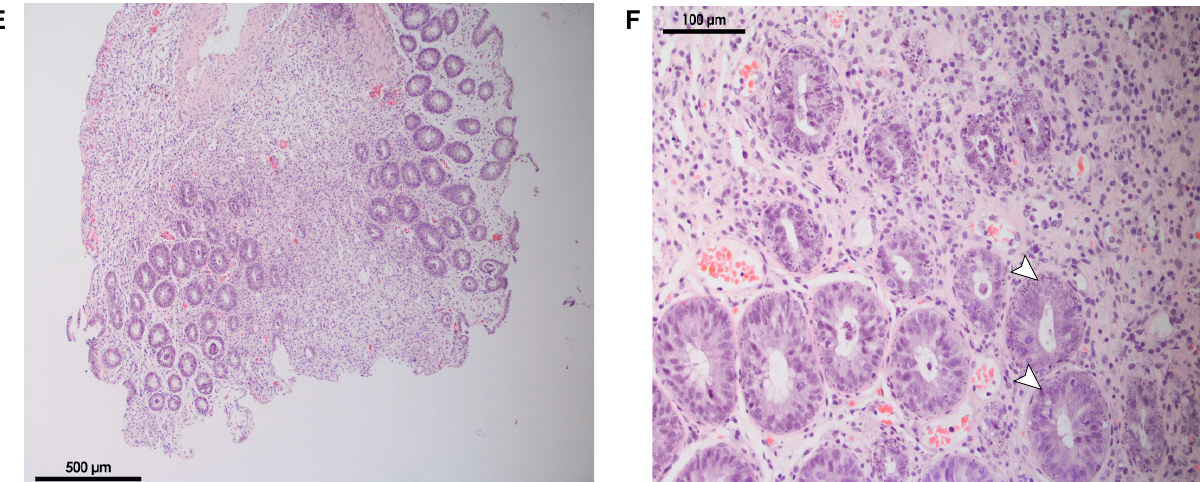
Figure 3. Ultrasound findings of another patient with acute GI GvHD and also an example of severe histopathological findings in GI GvHD. ( A – D ): B-mode and CEUS findings, including parametric imaging. Early arterial hyperenhancement of the intestinal wall (white arrows in A) and progressive transmural penetration of microbubbles (white arrows in B and C) compared with parametric images with early arterial hyperenhancement color coded in red and transmural penetration of microbubbles (white arrows). ( E,F ): Histology of colonic mucosa with severe acute GvHD (Lerner grade IV): denudation of mucosal epithelium, ulceration, and loss of crypts with abundant apoptosis in basal crypts (white arrows in F). (H&E staining, E: 50×, F: 200×).